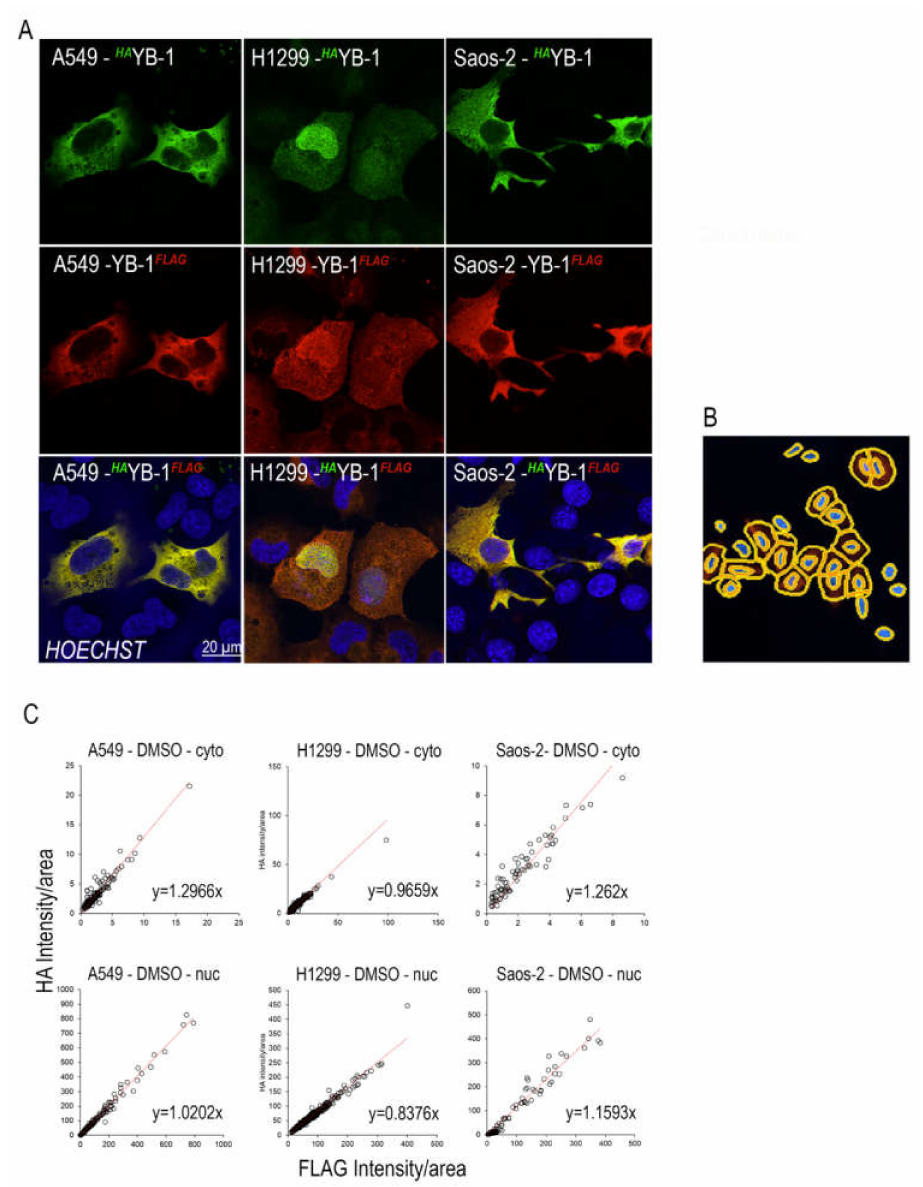
Figure 1. Full length YB-1 is present in the nuclear and cytoplasmic compartments. ( A ) Shows the nuclear and cytoplasmic location of HA YB-1 FLAG in A549, H1299 and Saos-2 cells. Top row shows anti-HA which detects the N-terminus of HA YB-1 FLAG , middle row shows anti-FLAG which detects the C-terminus of HA YB-1 FLAG and the bottom row shows the merged image. The nucleus is stained with Hoechst, anti-HA (green) and anti-FLAG (red). ( B ) shows examples of the nuclear and cytoplasmic mask used to determine cellular location of HA YB-1 FLAG . ( C ) the fluorescence intensity / area for anti-HA and anti-FLAG using this mask for > 100 cells in all three cell lines. Each dot represents the intensity / area for anti-HA and anti-FLAG for each cell and the slope of the line is